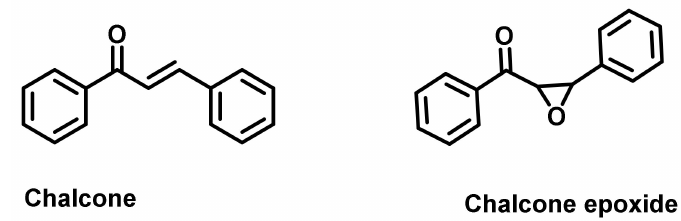
Figure 33. Chemical structure of chalcone and chalcone